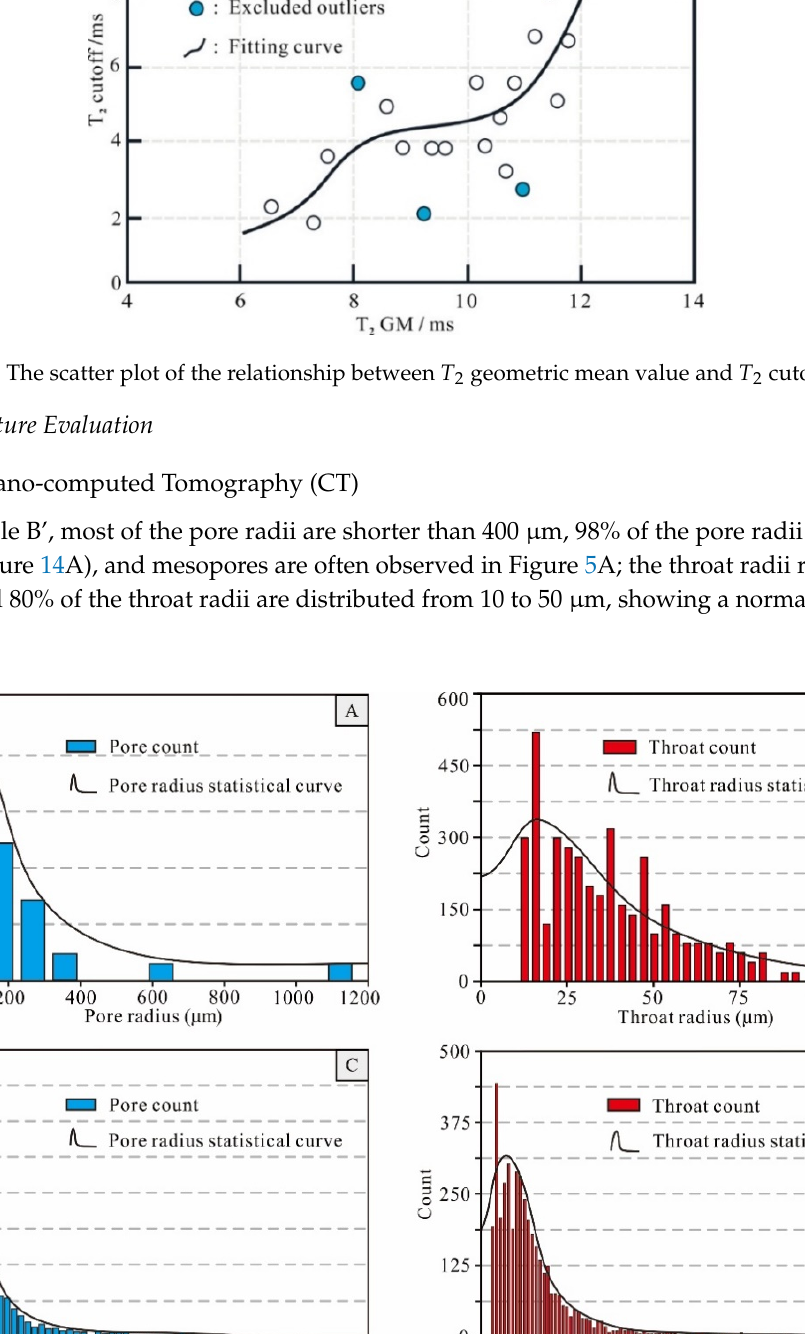
Figure 15. CT scan images of throat connectivity in the MSR and MCR. ( A ) MSR, intercepted from Figure 5B; ( B ) MCR, intercepted from Figure 5D1. The throat of MSR was well developed; the throats were connected with each other in a reticular morphology (Figure 15A), and the pores were effectively connected in series. Thus, the pore-throat connectivity of MSR will evidently improve, and it is beneficial in that it will increase the efficiency of fluid migration between pores. The permeability of MSR was good. Although the throats of MCR were well developed, the throat size was lower than that of MSR; the throats of MCR are distributed